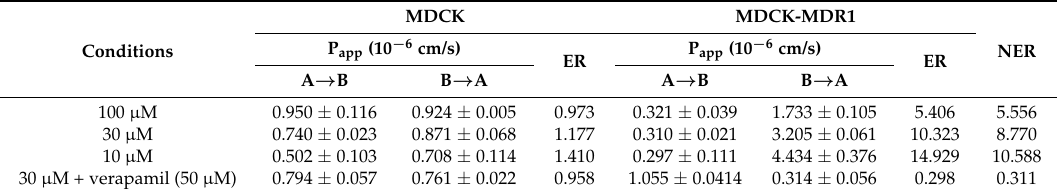
Table 2. The transcellular transport of DL0410 across MDCK and MDCK-MDR1 cell monolayers. (Mean ± SD, n = 3).